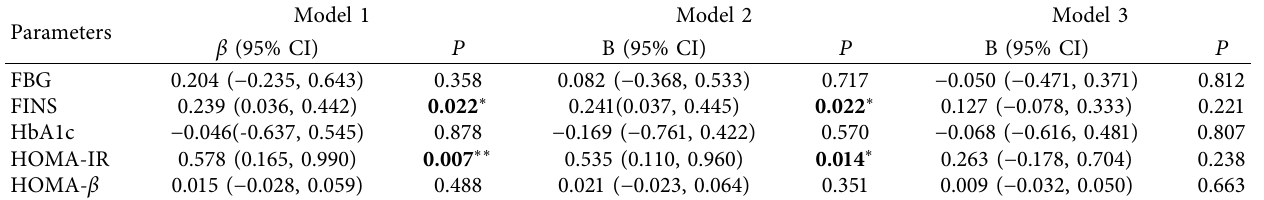
Table 2: Associations between IFPD and glycemic parameters in 80 individuals with newly diagnosed T2DM.